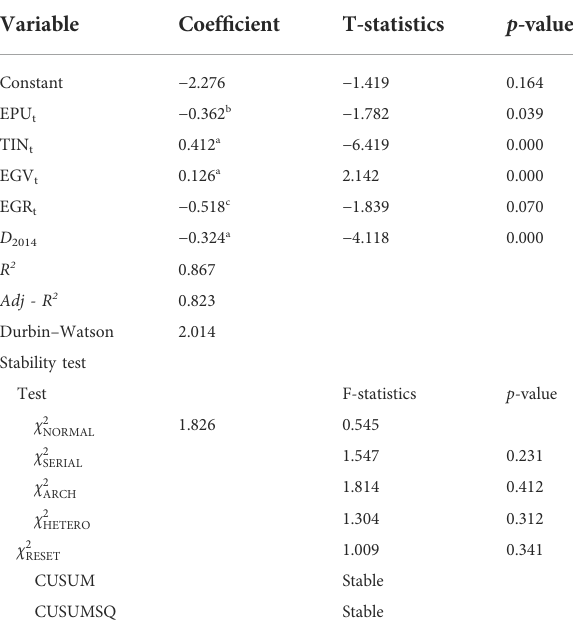
TABLE 5 BARDL cointegration analysis: long-run fi ndings. Dependent variable = GET t